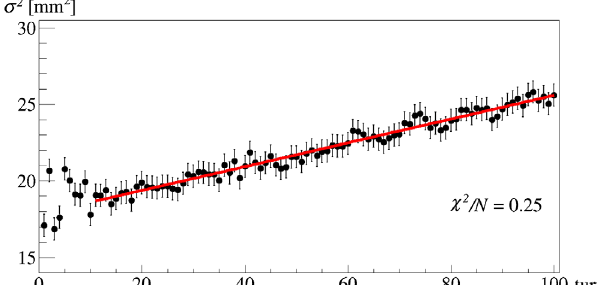
FIG. 3. Average of the beam sizes of five shots for each turn shown as plots. The error bars are the RMS of the five shots. The first 10 data points show fluctuations because of the beta mismatch at the injection. The red line represents the linear fitting to the plots.